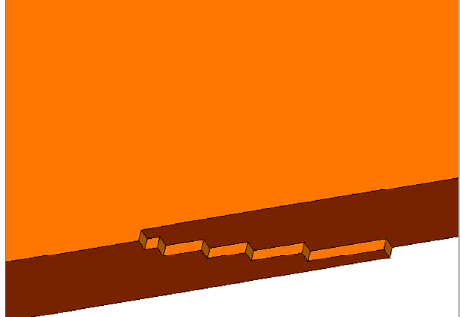
Figure 12: Crack front shape resulting from elements extinction.